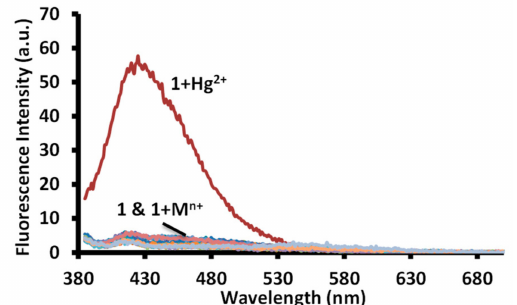
Figure 11. Change in fluorescence spectra of solutions of receptor 1 in water (pH = 7.6, 1.0 mM HEPES) upon addition of acetate salts of di ff erent metal ions. [ 1 ] = 20 µ M = [M n + ] = Hg 2 + , Na + , K + , Li + , Cr 3 + ,